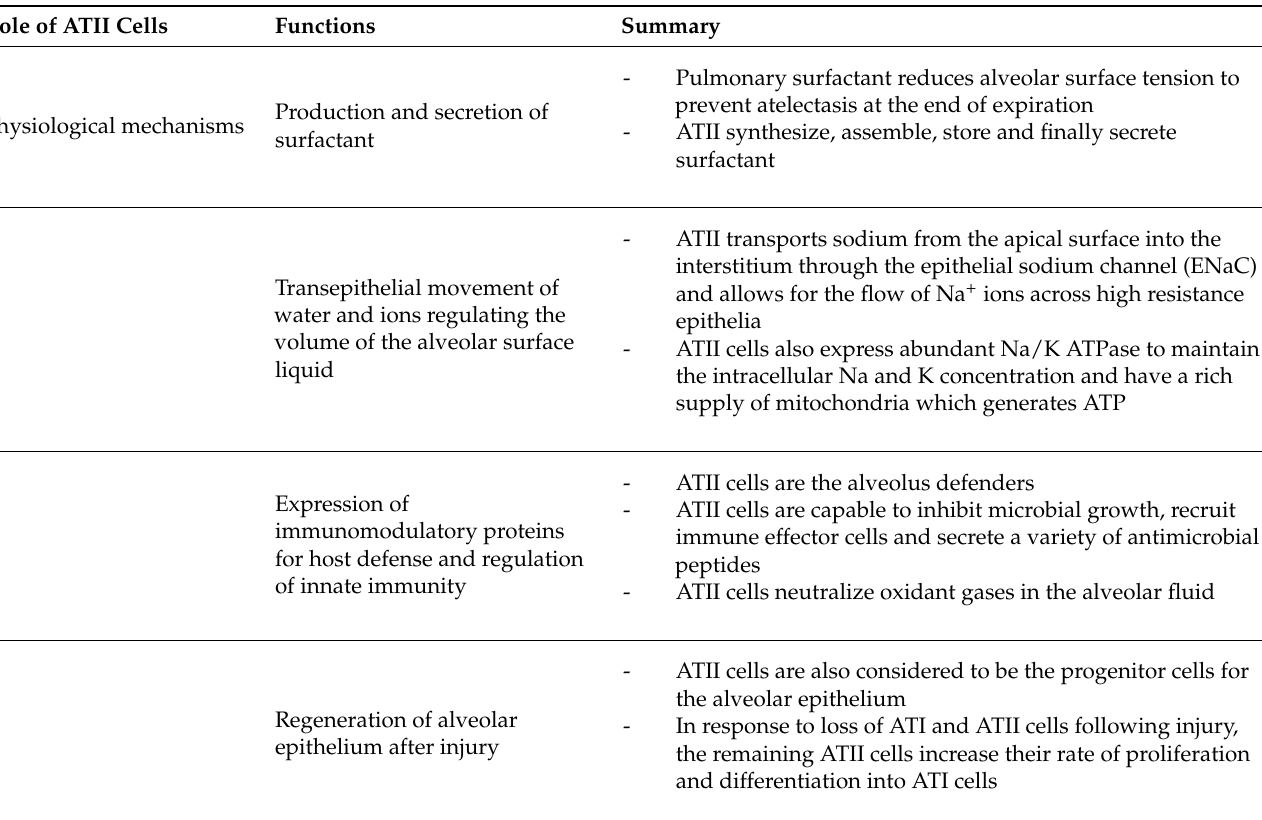
Table 1. Summary of physiologic and pathologic roles of alveolar epithelial type II (ATII) cells in pulmonary diseases. Role of ATII Cells Functions